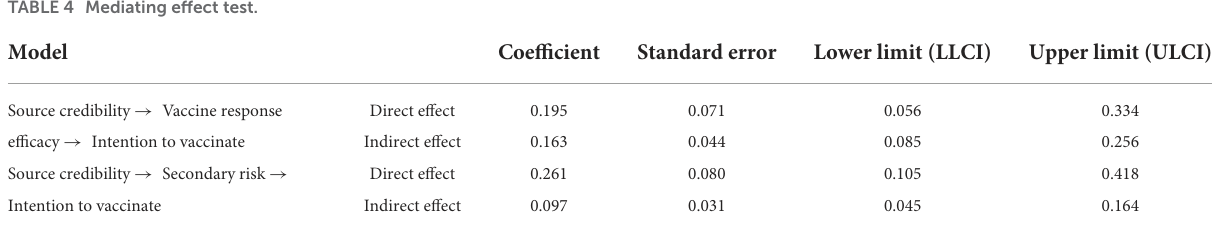
TABLE 4 Mediating effect